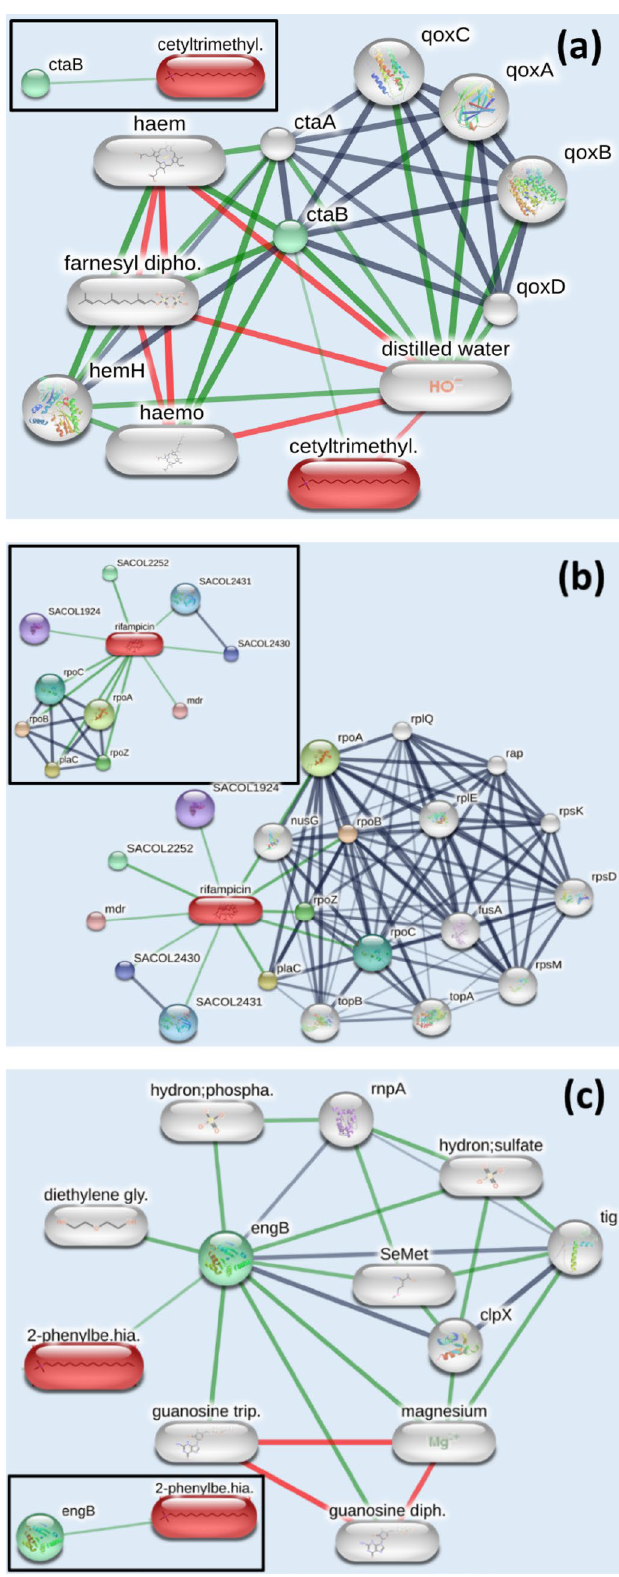
Figure 7. Direct and indirect compound protein interactions of ( a ) CTAB ( b ) Rifampicin (RF) and ( c ) Benzothiazole (BT) on MRSA. The inset for each shows the direct interactions